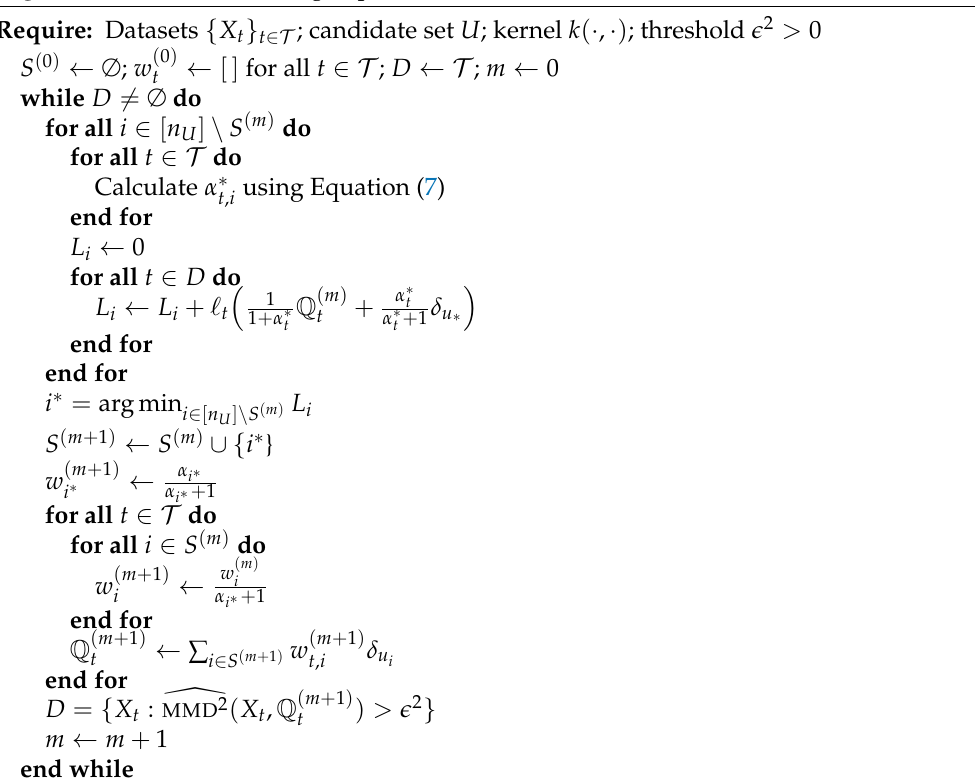
Algorithm 1 DMMD : Selecting dependent MMD